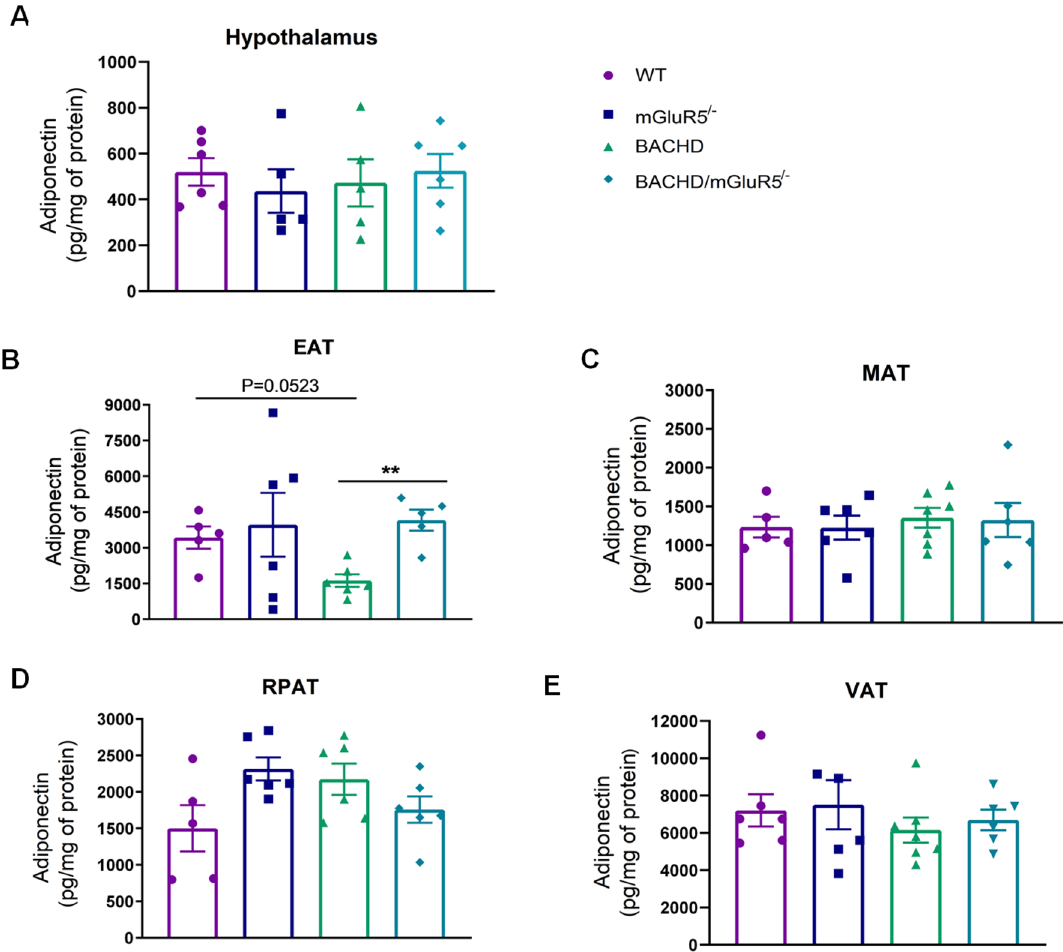
Figure 4. The deletion of mGluR5 restores adiponectin levels in the epididymal adipose tissue of BACHD mice. ( A – E ) Adiponectin levels in the hypothalamus, epididymal (EAT), mesenteric (MAT), retroperitoneal (RPAT) adipose tissues, and in the sum of visceral adipose tissues (VAT) of WT, mGluR5 −/− , BACHD and BACHD/ mGluR5 −/− mice at 12 months of age. Error bars represent the mean ± SEM; n = 5–7. One-Way ANOVA followed by Bonferroni post test ( A , C – E ), and One-Way Welch ANOVA followed by Games-Howell’s post test ( B ). * p < 0.05; ** p <